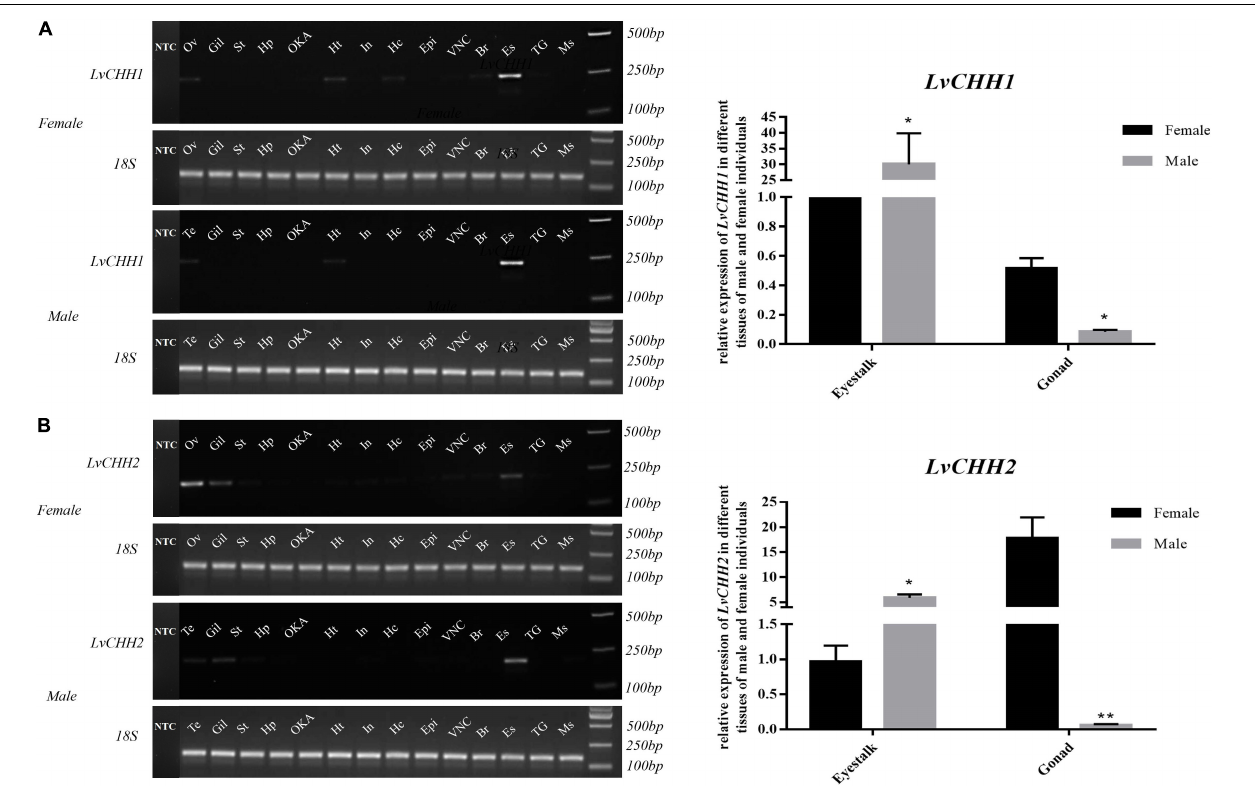
FIGURE 4 | Distribution analysis of LvCHH1 (A) and LvCHH2 (B) in different tissues of male and female L. vannamei by RT-PCR and qPCR. 18S rRNA gene was used as the internal reference. Ov, ovary; Te, testis, Gil, gill; St, stomach; Hp, hepatopancreas; OKA, lymph organ; Ht, heart; In, intestine; Hc, hemocyte; Epi, epidermis; VNC, ventral nerve cord; Br, brain; Es, eyestalk; TG, thoracic ganglia; Ms, muscle; NTC, no-template controls (which were detected separately on another gel). Expression levels of target genes were detected in three replicates for each tissue. Significant differences of the gene expression levels were marked with one ( P < 0.05) or two ( P < 0.001)